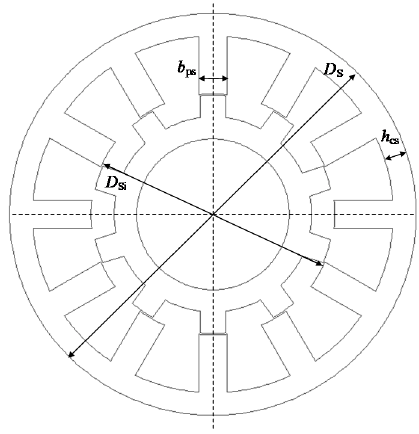
Figure 4. Schematic of parameters in six-phase SRM. Table 2. Optimization parameters and their